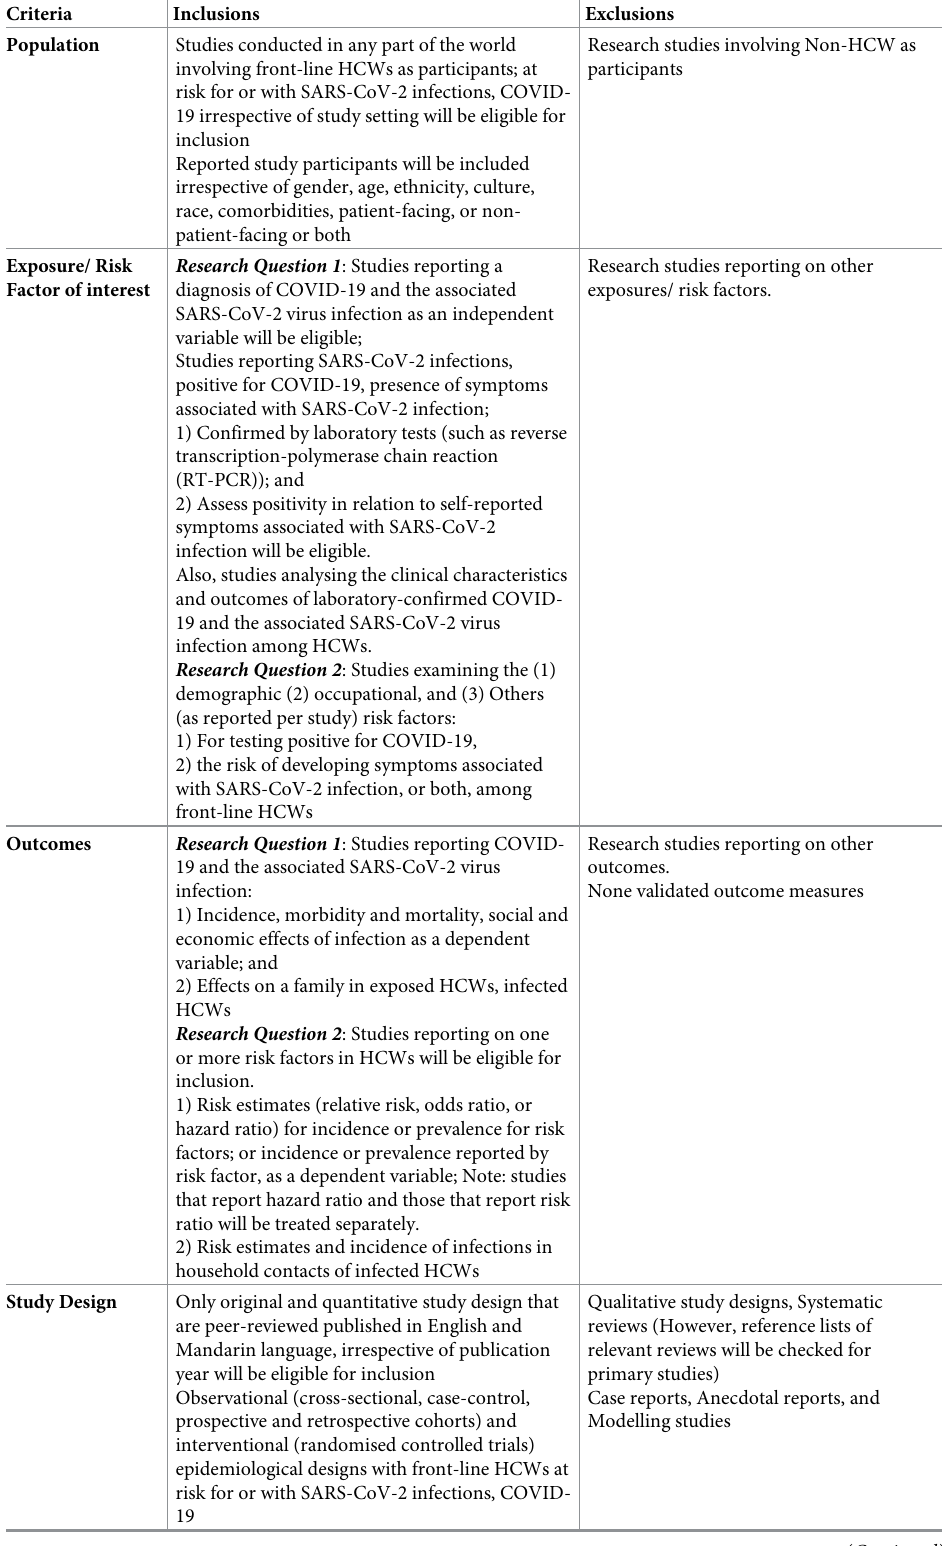
Table 2. Eligibility criteria according to the PEOd-T nomenclature